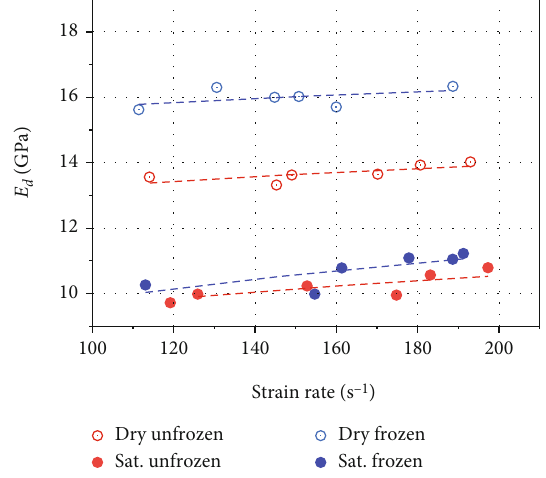
Figure 10: Variations in E